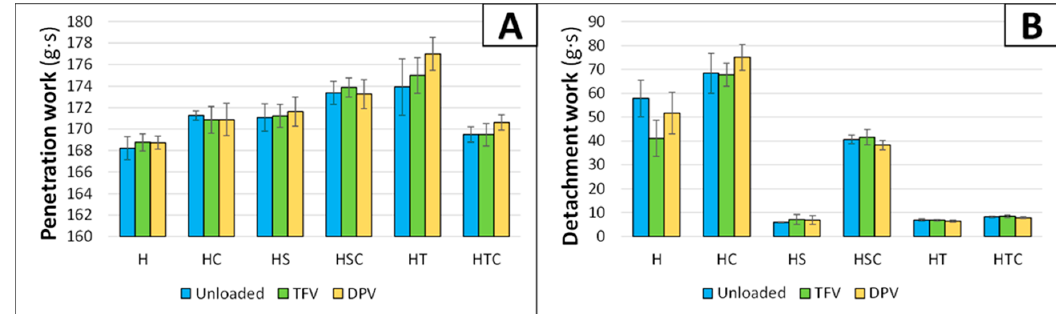
Figure 3. Penetration work ( A ) and detachment work ( B ) for each batch of gels. Mean ± SD are presented ( n = 9). Table 2. p -Values obtained in the comparison of the group of batches by a paired t -test. Significant di ff erences are in